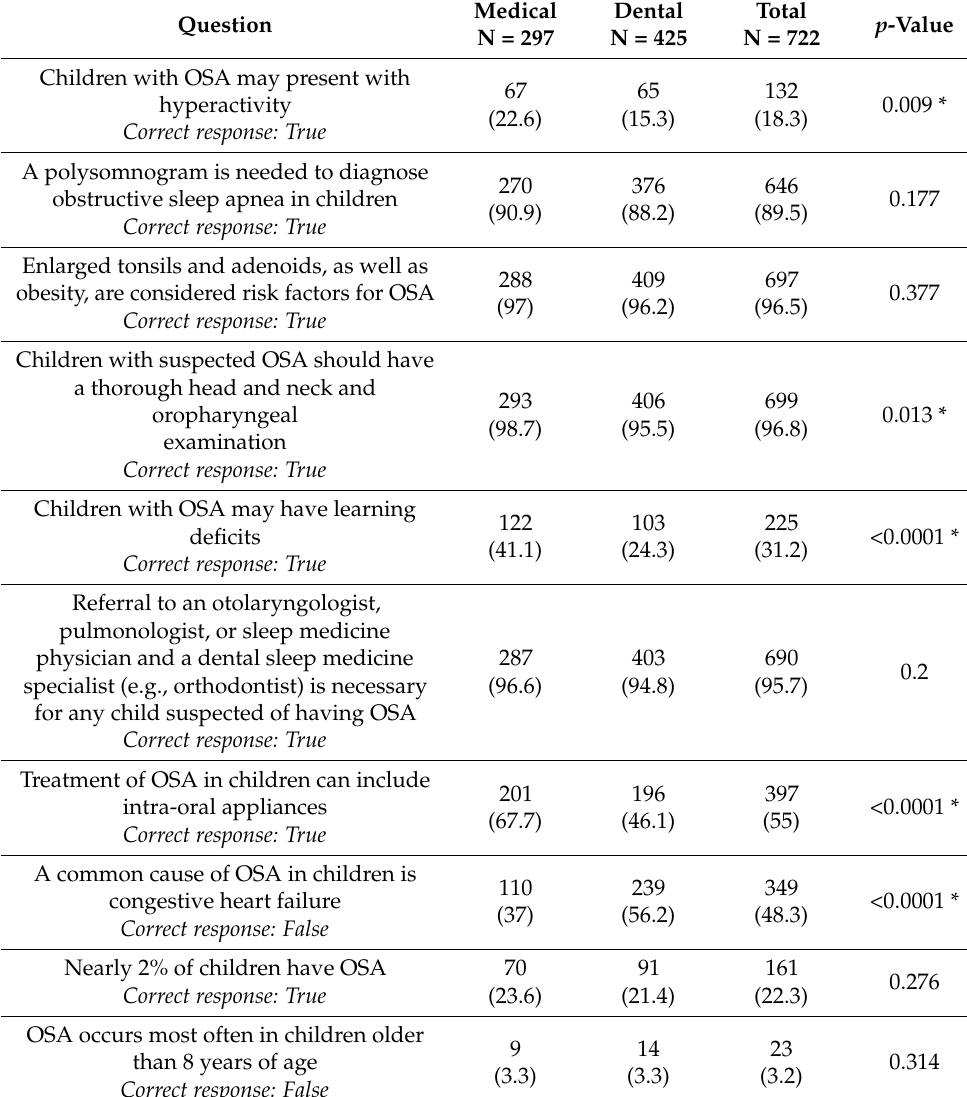
Table 1. Frequency (percentage) of the correct answer in general knowledge questions about pediatric